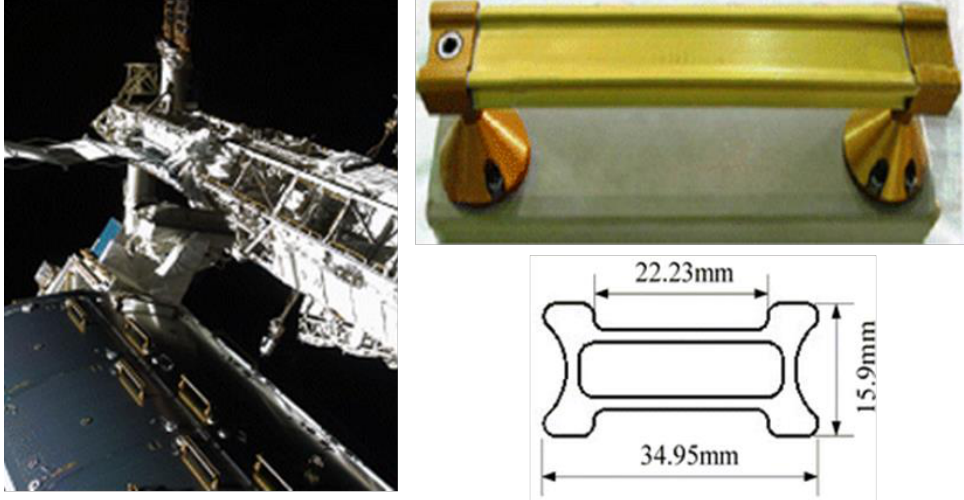
Figure 2. Example of Handrails for astronaut movements detail [22].